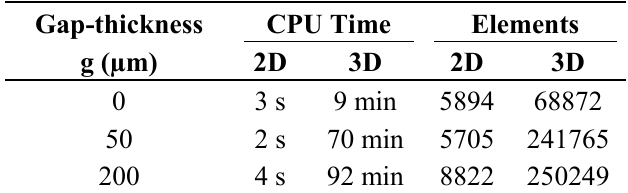
Table 4. Computational cost for the 2D and 3D simulations using the 15-turn E20/10/5 inductor.